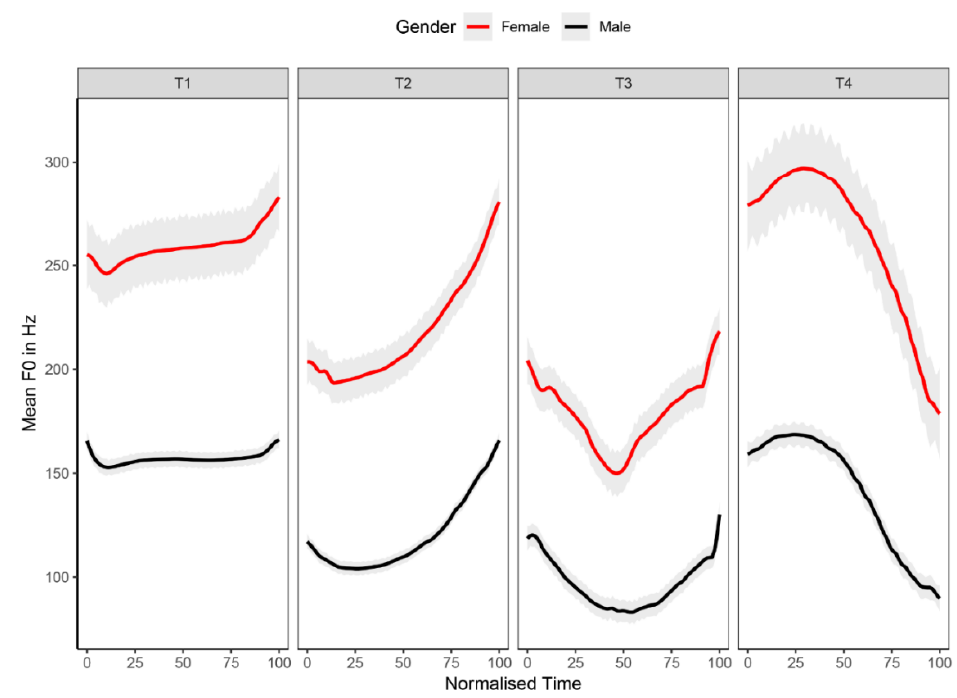
Figure 2. Pitch contours of the lexical tone recognition materials. Grey shades indicate standard error.